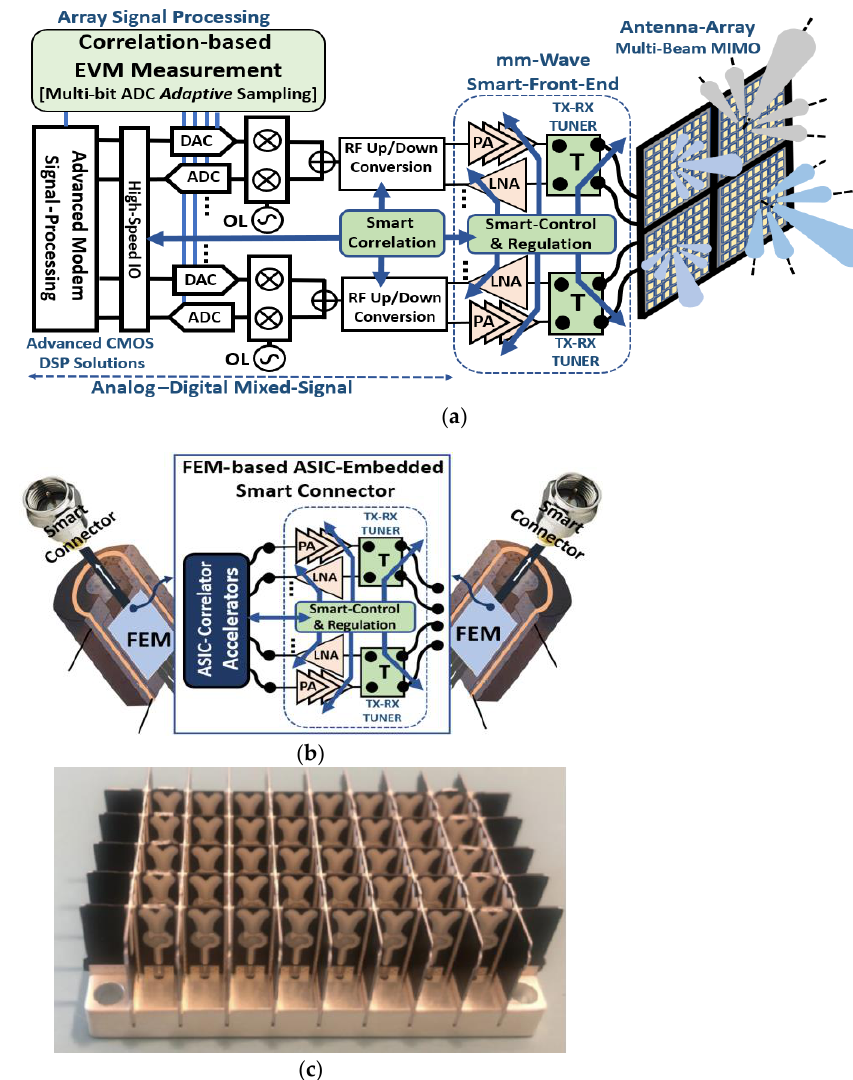
Figure 1. ( a ) Wireless adaptive front-end modules including advanced auto and cross-correlation signal processing and multi-beam MIMO antennas. ( b ) Smart connectors with embedded front-end modules. ( c ) Dual-polarization probe-array using Vivaldi antennas.